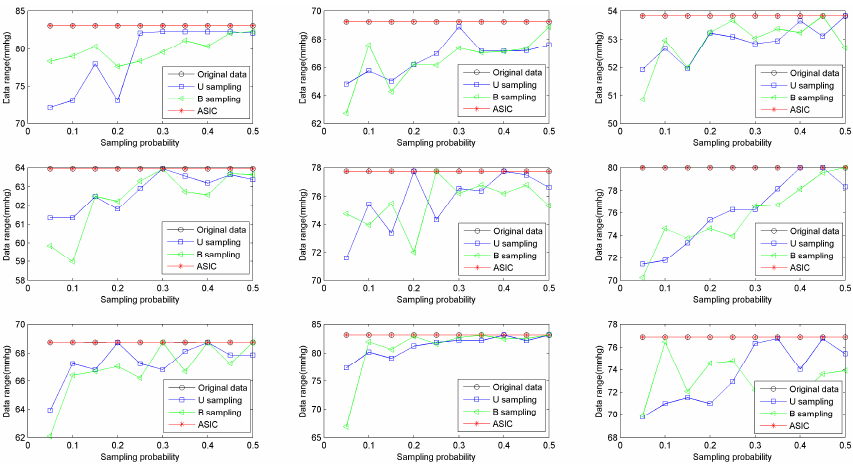
Figure 3. Data range affected by sampling probability in a real dataset.